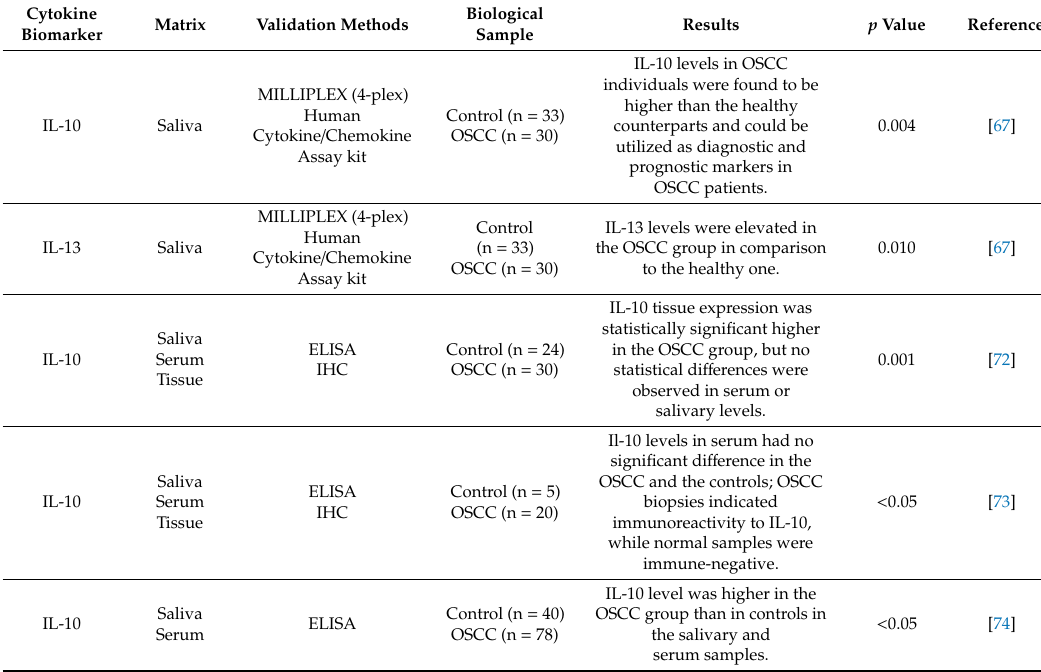
Table 2. Summary of included studies related to IL-10 and IL-13 and